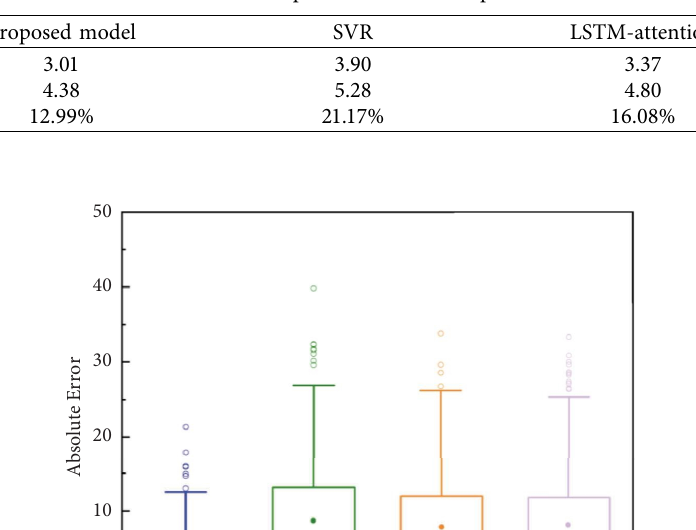
Table 2: Te experiment result comparison.